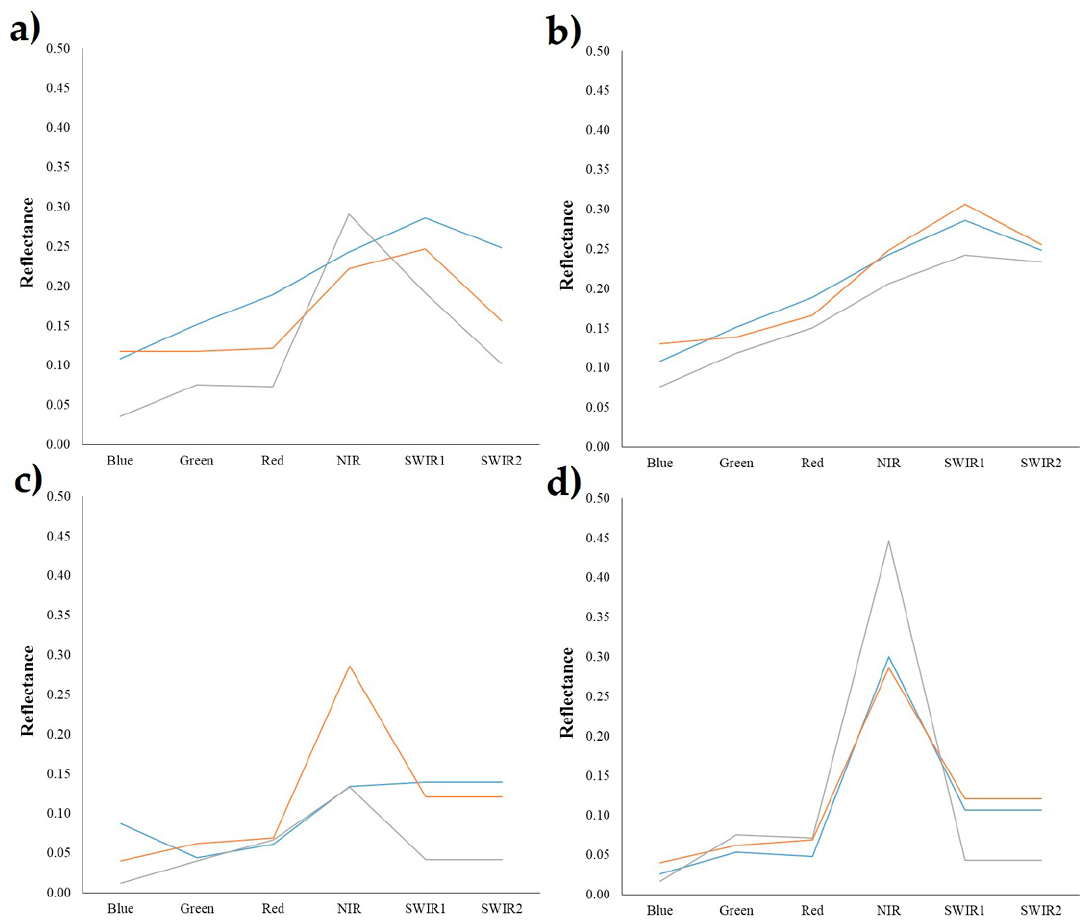
Figure 6. Spectral response of each correction method in Eden for 2010 ( a ); 2011 ( b ); 2013 ( c ); 2014 ( d ); ATCOR2 ( — ), DOS1 ( — ) and FLAASH ( — ). NIR: near infra-red; SWIR: shortwave infra-red.